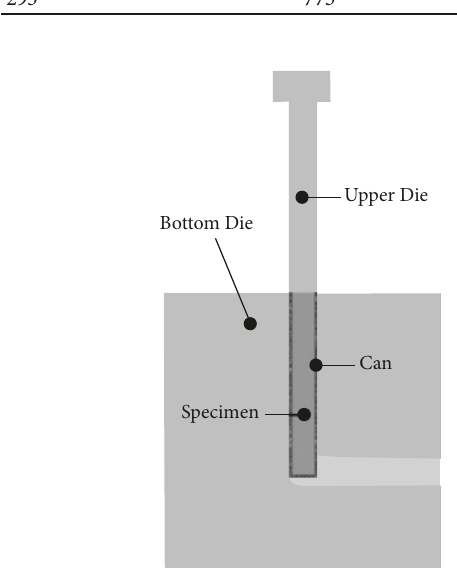
Figure 11: ECAP model with can based on finite element